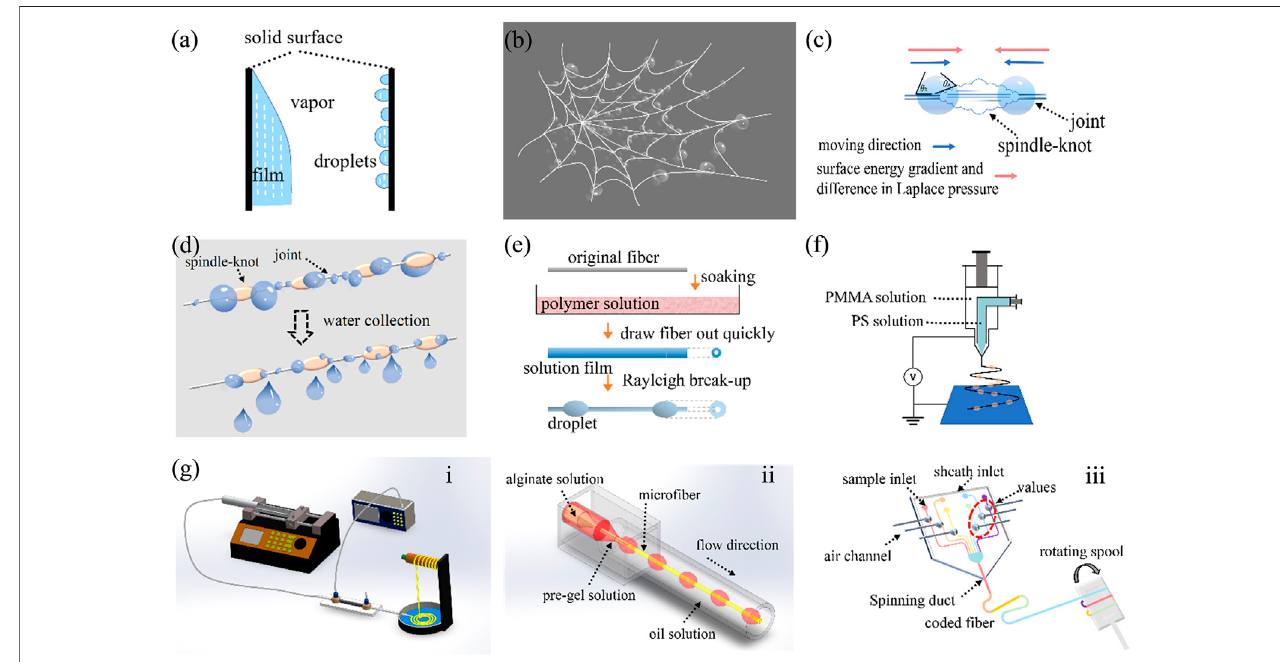
FIGURE 1| Principles, fabrication and application ofBioinspired fi ber for directionaldropletself-transportation. (A) Twocondensation modes; (B) Water collection on spider silks; (C) Mechanism of directional droplet self-transportation; (D) Water-harvesting behavior of bioinspired micro fi bers; (E) Dip-coating method; (F) Electrospinning, method; (G) Micro fl uidic method, i) Emulsion-based coaxial micro fl uidic method, ii)Integrative spinning-coating-emulsi fi cation coaxial capillary micro fl uidic method, iii) Pneumatic-valve micro fl uidic chip spinning